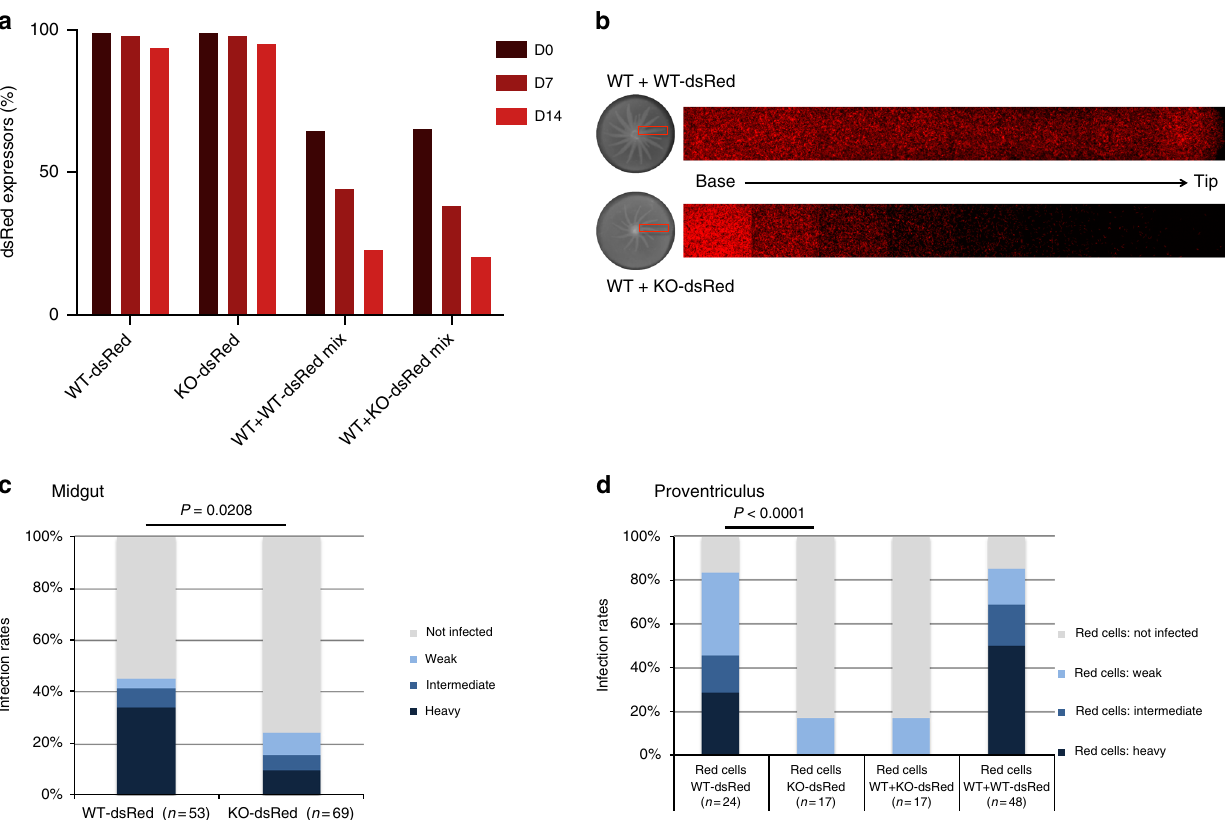
0%20%40%60%80%100% WT-dsRed ( n =53) KO-dsRed ( n =69) Fig. 6 WT does not complement PDEB1 KO in vitro or in vivo. a Proportion of dsRed-positive cells in suspension culture. Fluorescence was monitored by fl ow cytometry (Supplementary Figure 2). Tagged:untagged cells were mixed at a ratio of 2:1. b WT-dsRed or KO-dsRed was mixed with untagged WT at a ratio of 2:1 and tested for SoMo. Top panel: WT + WT-dsRed co-culture. WT-dsRed parasites are evenly distributed throughout the projections. Lower panel: KO + WT-dsRed co-culture. KO-dsRed cells form a gradient with a high proportion of KO-dsRed cells at the base of the projection and progressively fewer cells extending to the tip. c Prevalence and intensities of midgut infections at day 14 post infection. P -value is shown for Fisher ’ s exact test, two-sided. d Proventriculus infection rates at day 14 post infection. In the mixed infections, only dsRed cells were scored. P -value is shown for Fisher ’ s exact test,